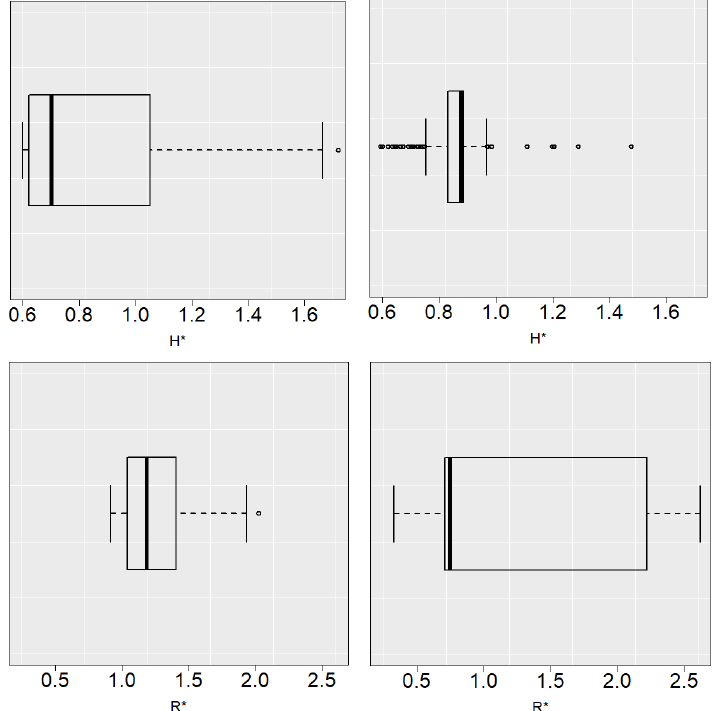
,..., H ∗ values ( top ) and boxplot of R ∗ N 1